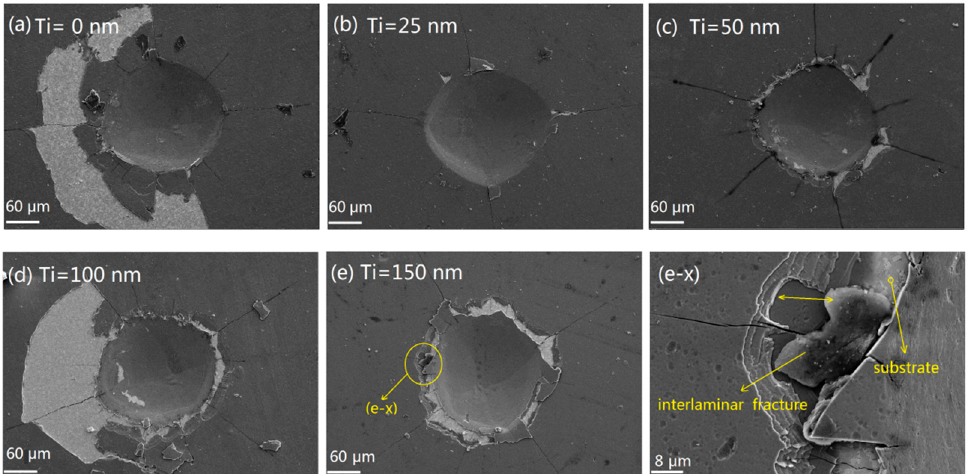
Figure 8. Rockwell indentation images of sample ( a ) #S1 (Ti-0 nm), ( b ) #M2 (Ti-25 nm), ( c ) #M3 (Ti-50 nm), ( d ) #M4 (Ti-100 nm), ( e ) #M5 (Ti-150 nm), ( e-x ) partial enlarged image of ( e ).